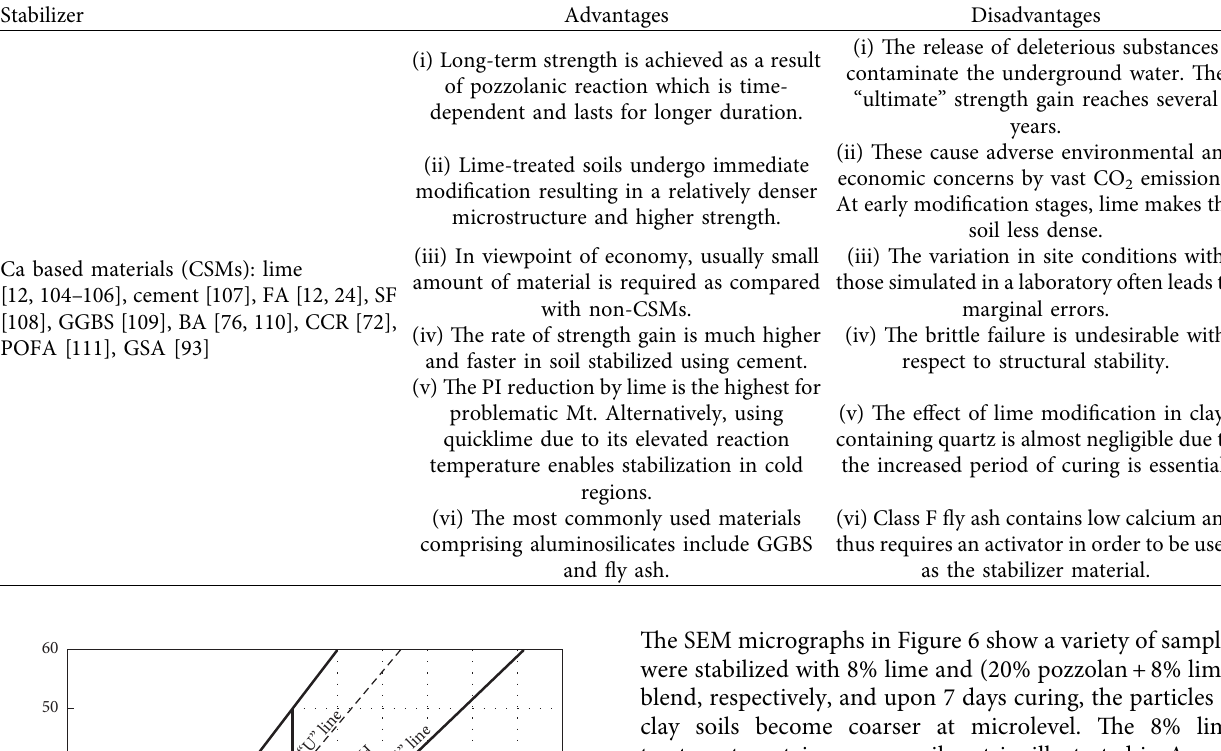
Table 4: Summary of advantages and disadvantages of calcium-based stabilizer materials (CSMs).